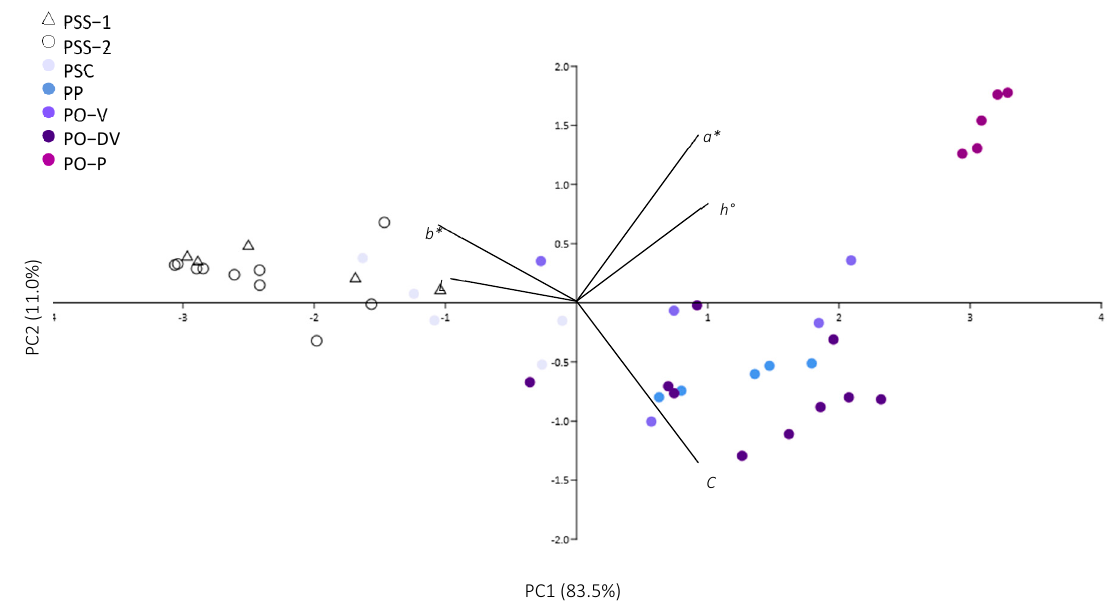
Figure 2. Principal component analysis of colorimetric variables in Phyteuma . PSS-1: P. spicatum